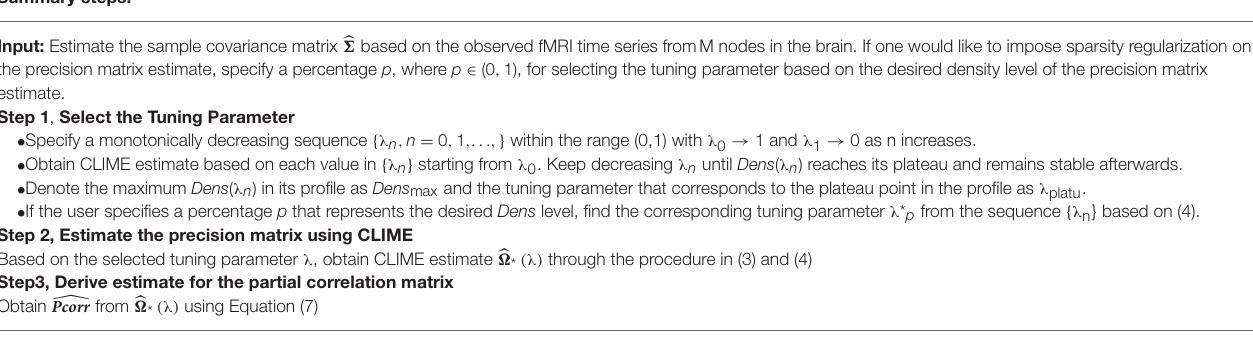
TABLE 1 | Proposed Dens -based partial correlation estimation approach. Summary